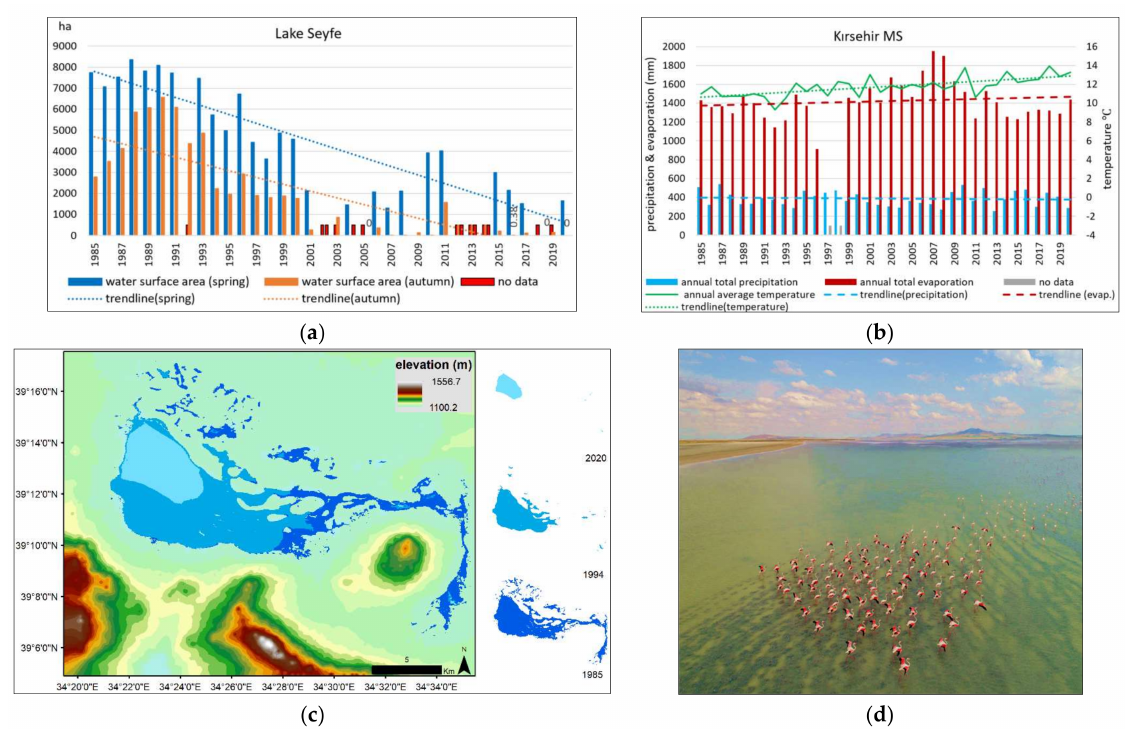
Figure 6. Lake Seyfe: ( a ) 1985–2020 annual (spring and autumn) surface water areas; ( b ) representative meteorological station data (precipitation, evaporation, and temperature); ( c ) water surface area change in spring (NDWI); ( d ) view of the lake [82].